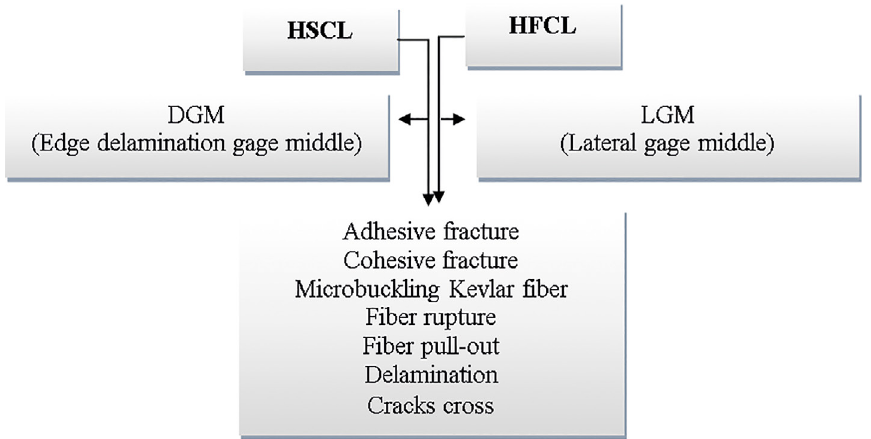
Figure 14. Flowchart: tensile fracture